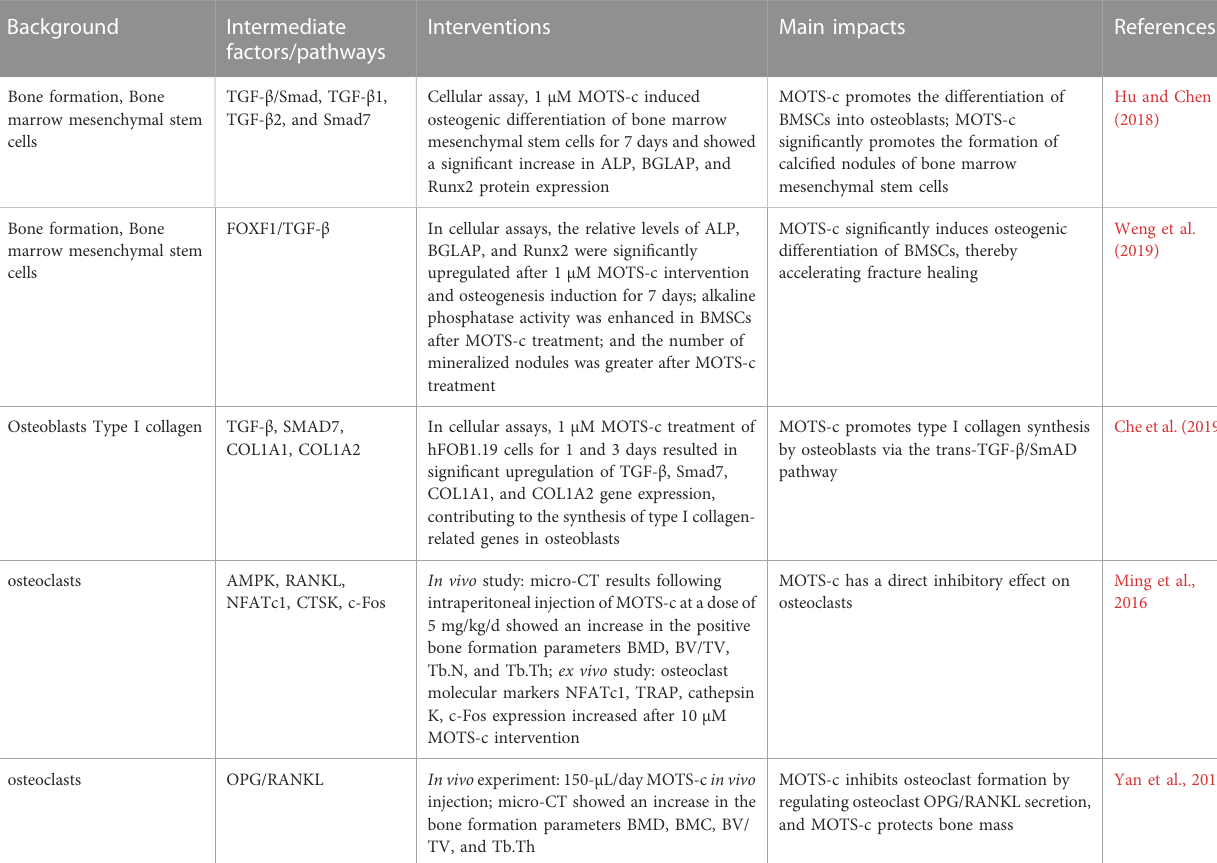
TABLE 1 Effect of MOTS-c on bone